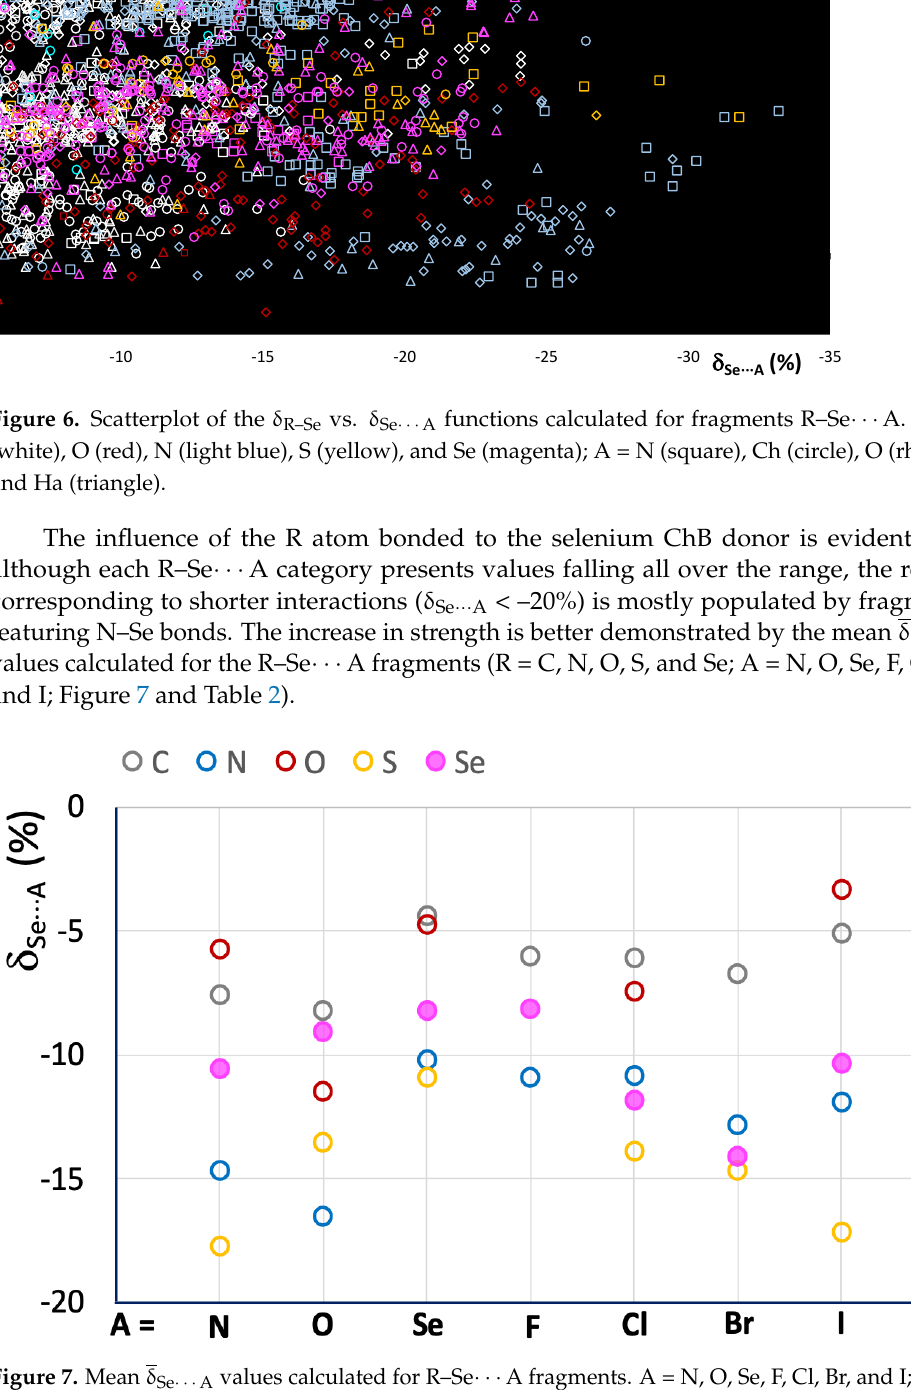
Figure 7. Mean δ Se ··· A values calculated for R–Se · · · A fragments. A = N, O, Se, F, Cl, Br, and I; R = C Figure 7. Mean δ̅ Se···A values calculated for R – Se···A fragments. A = N, O, Se, F, Cl, Br, and I; R = C (grey), N (blue), O (red), S (yellow), and Se (filled magenta (grey), N (blue), O (red), S (yellow), and Se (filled magenta circles). Table 2. Mean of δ Se···Aa values ( δ̅ Se···A ) and Nc b values calculated for the fragments R – Se···A. R = C, N, O, S, and Se; A = N, O, S, Se, Te, F, Cl, Br, and I.